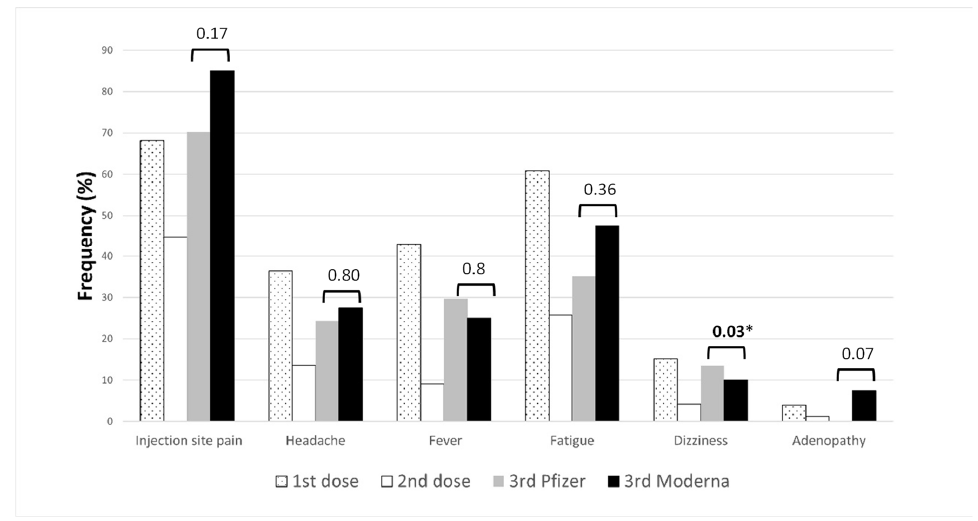
Figure 2. Adverse effects among people vaccinated with a double dose of AstraZeneca. bars represent p -values. * p -values < 0.05.